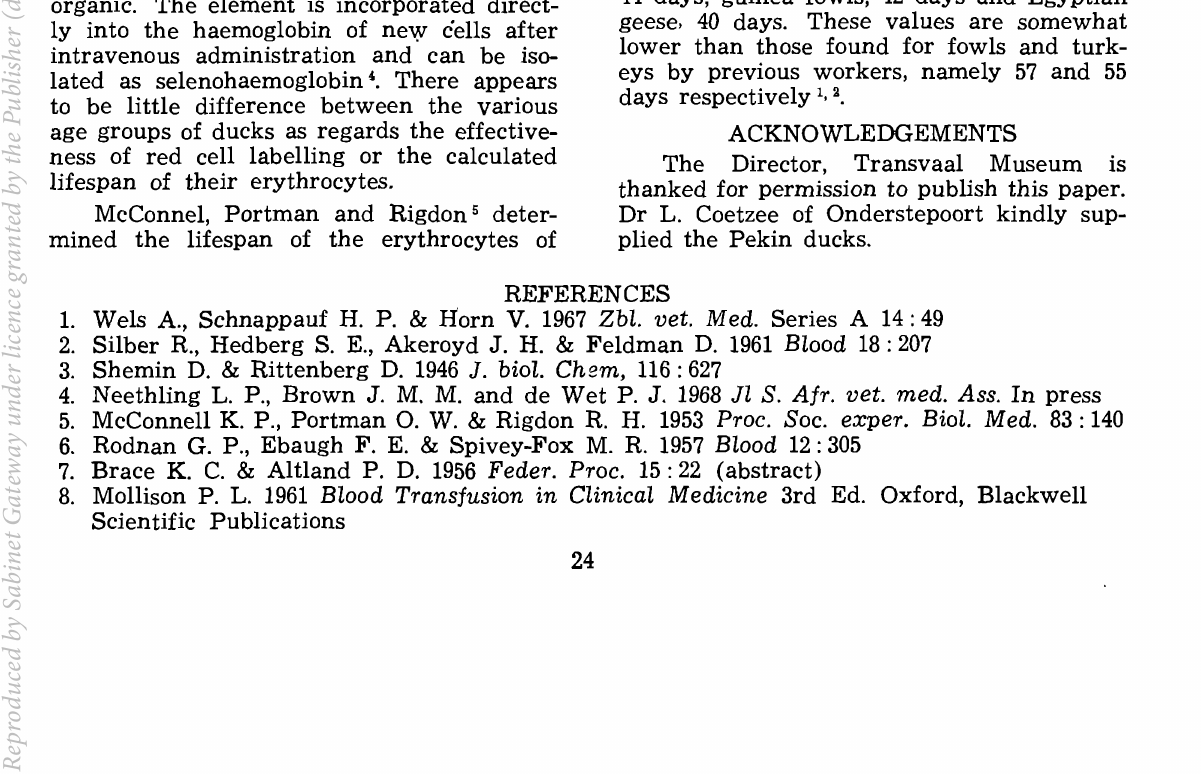
Table 2 that it is immaterial whether the form of selenium used for in vivo labelling of the erythrocytes of birds is inorganic or ly into the haemoglobin of new cells